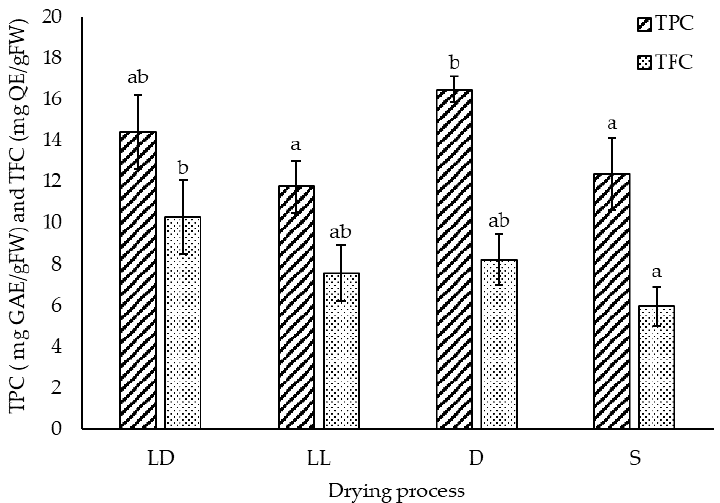
Figure 2. The total polyphenol content (TPC) expressed in milligram gallic acid equivalents (mg GAE) and total flavonoid content (TFC) in milligram quercetin equivalents (mg QE) per gram of fresh weight (FW) measured in ethanolic extracts of Agave lechuguilla bagasse freeze-dried in the dark (LD), exposed to light (LL), oven-dehydrated (D), and sun-dried (S). The given letters “a”, “b”, and “ab” indicate significant differences as per Tukey HSD analysis for TPC and TFC data, respectively (n = 12, p < 0.05).